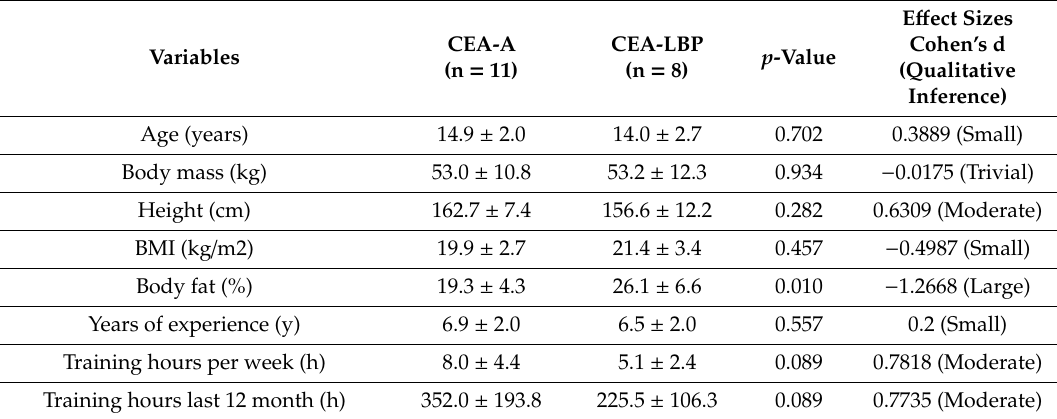
Table 3. Comparative analysis between equestrian athletes with a previous history of LBP and asymptomatic ones. Data are expressed as mean ± standard